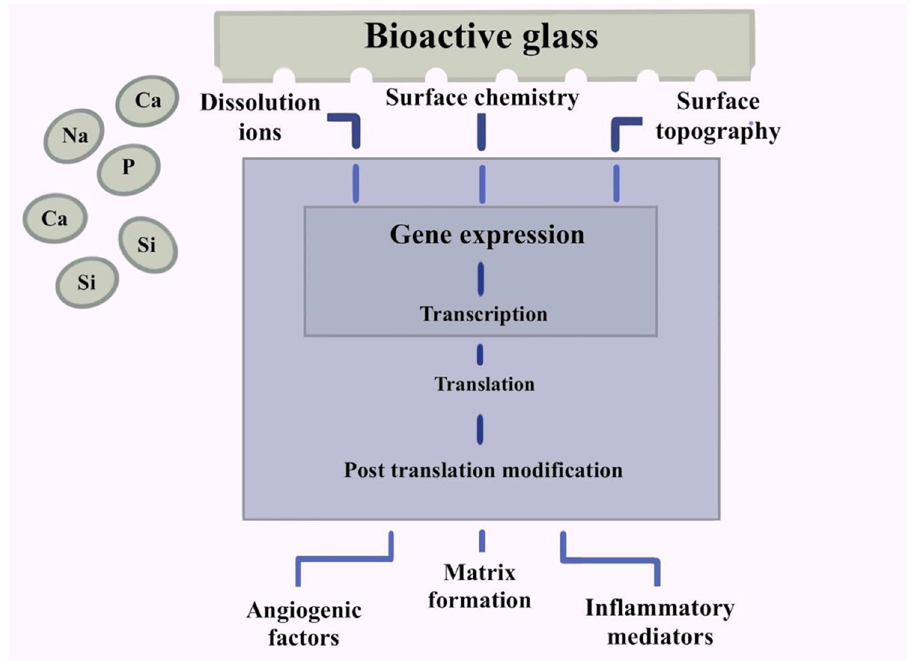
Figure 2. The structure of bioactive glass.